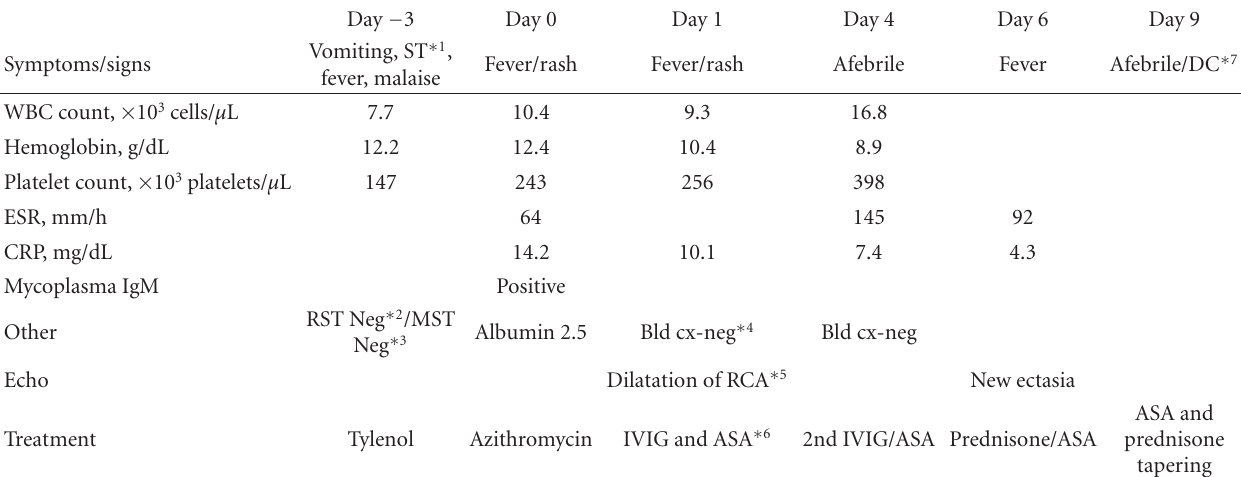
Table 1: First hospital admission inpatient